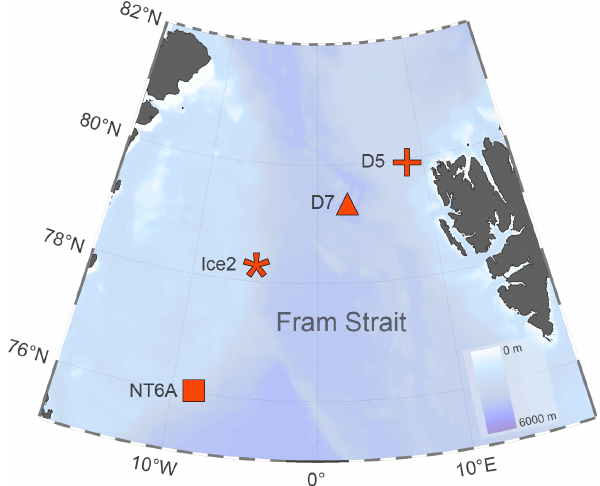
Figure 1. Map showing the locations where incubation experiments were performed (stations NT6A, Ice2, D7 and